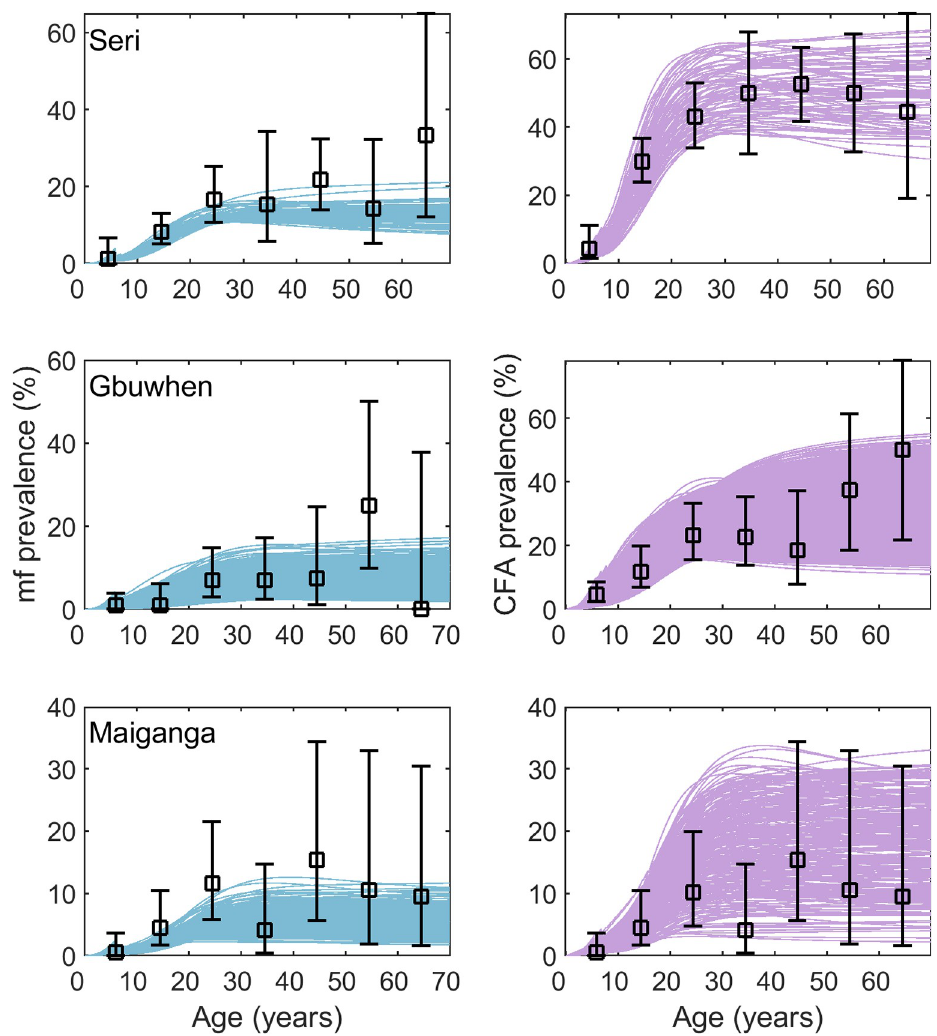
Fig 3. Model fits to 2003 mid-MDA mf and CFA survey data. Each row of plots give the mf (left, blue curves) and CFA (right, purple curves) age prevalence fits for the given site to data from the first LF survey in 2003 (after years of MDA for onchocerciasis had already occurred). The curves represent the model-predicted infection by age compared to the observed age infection profiles (black points with 95% confidence intervals). https://doi.org/10.1371/journal.pcbi.1007506.g003 Table 3. Model-predicted age-stratified mf and CFA prevalence (median and 95% CI) for Seri, Gbuwhen, and Maiganga, Nigeria in 2003 1 . Seri Gbuwhen